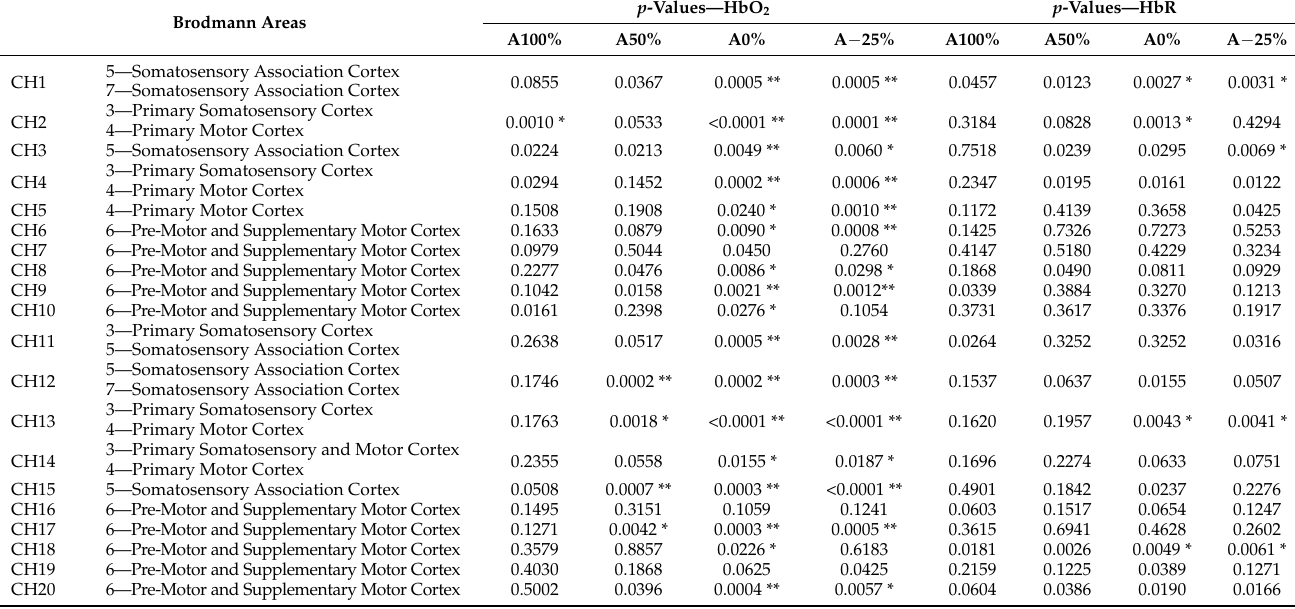
Figure 4. Mean activation maps of cerebral cortex for HbO 2 and HbR during gait for each level of assistance (A100%, A50%, A0%, A − 25%). The data are t values, t: statistical value of sample t-test with a significance level of p < 0.05 (Benjamini – Hochberg correction). The change from red to yellow indicates that the degree of activation is from low to high. The coordinates in the figure show the activation range of the cerebral cortex in each level of assistance. Only statistically significant responses were illustrated. The data and maps were calculated and generated by NIRS-SPM. Table 1. Changes in Hb0 2 and HbR levels between rest and task for each condition. Brain regions over which the channels were located and the corresponding p -values (indicating change from rest to the task) for oxyhemoglobin (HbO 2 ) and deoxyhemoglobin (HbR) levels for each